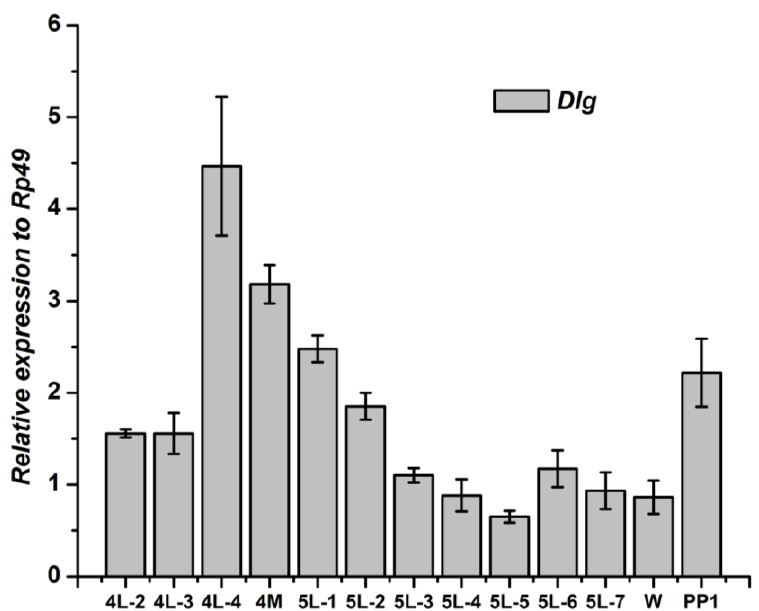
Figure 6. Developmental changes of Dlg mRNA in fat body of Bombyx mori.